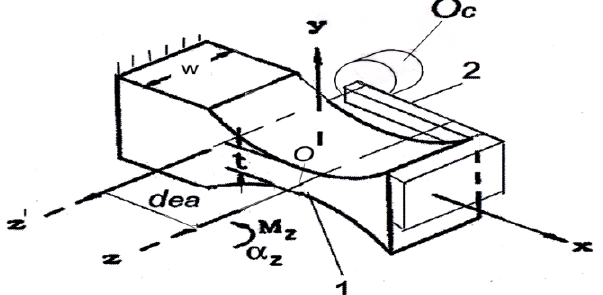
Figure 6. ICR of notch hinge1 position on the virtual axis z’ rotation in part 2 with of radius ρ (reprint from [17] with the AIP cylindrical surface O c